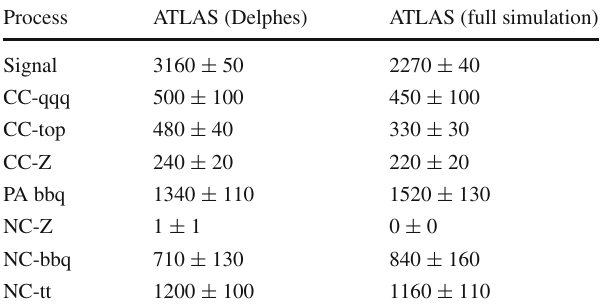
(cid:4) Ldt = 1 ab − 1 , for both